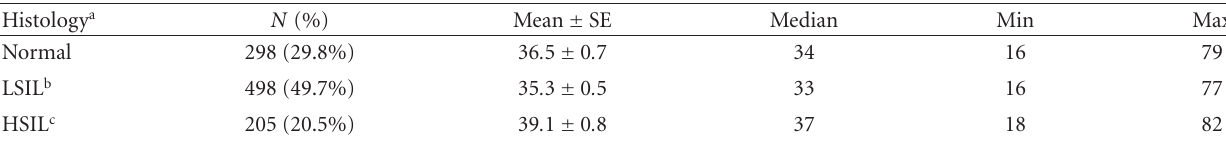
Table 1: Summary statistics for age by histological results.